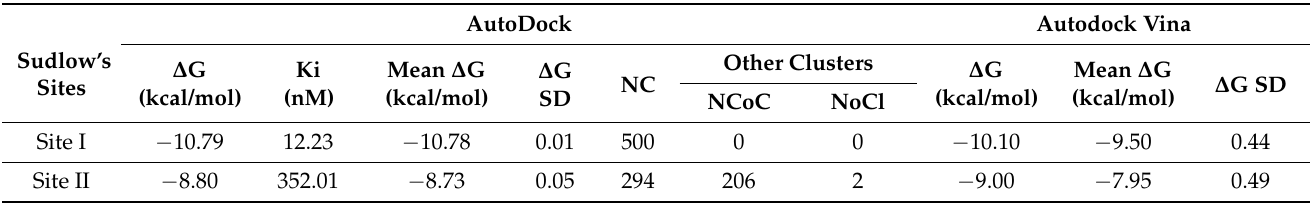
Table 1. The results of the docking study expressed as binding affinity of phthaloNH 2 to site I and site II of serum albumin expressed as variation of Gibbs free energy ( ∆ G), the computed inhibition constant (Ki), and the analysis of clusters. AutoDock Autodock Vina Sudlow’s ∆ Sites